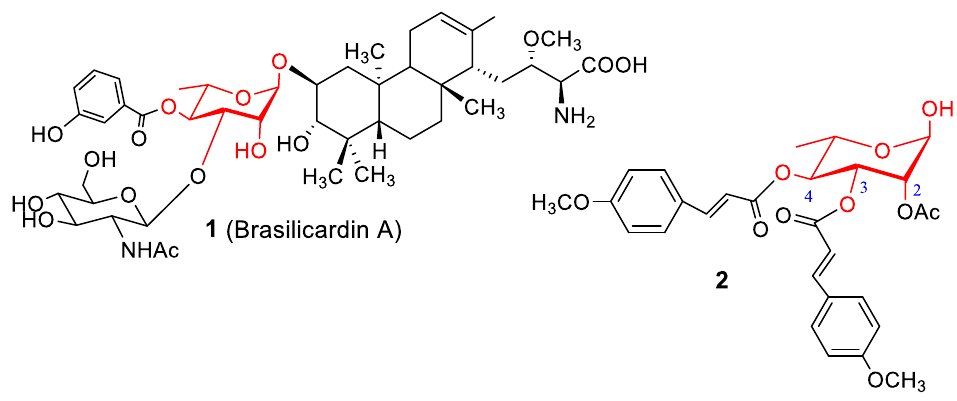
Figure 1. Bioactive natural rhamnose